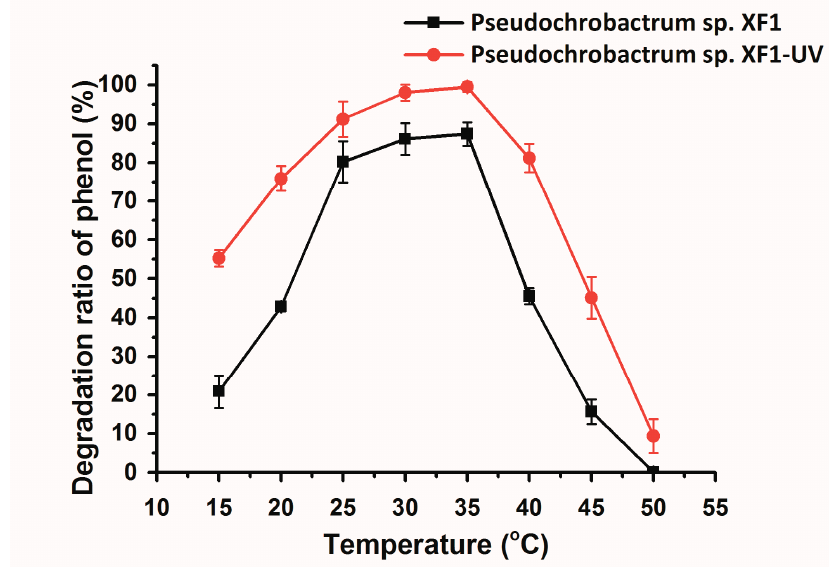
Figure 4. The effect of temperature on phenol degradation by Pseudochrobactrum sp. XF1 and Pseudochrobactrum sp. XF1-UV. Error bars indicate the standard